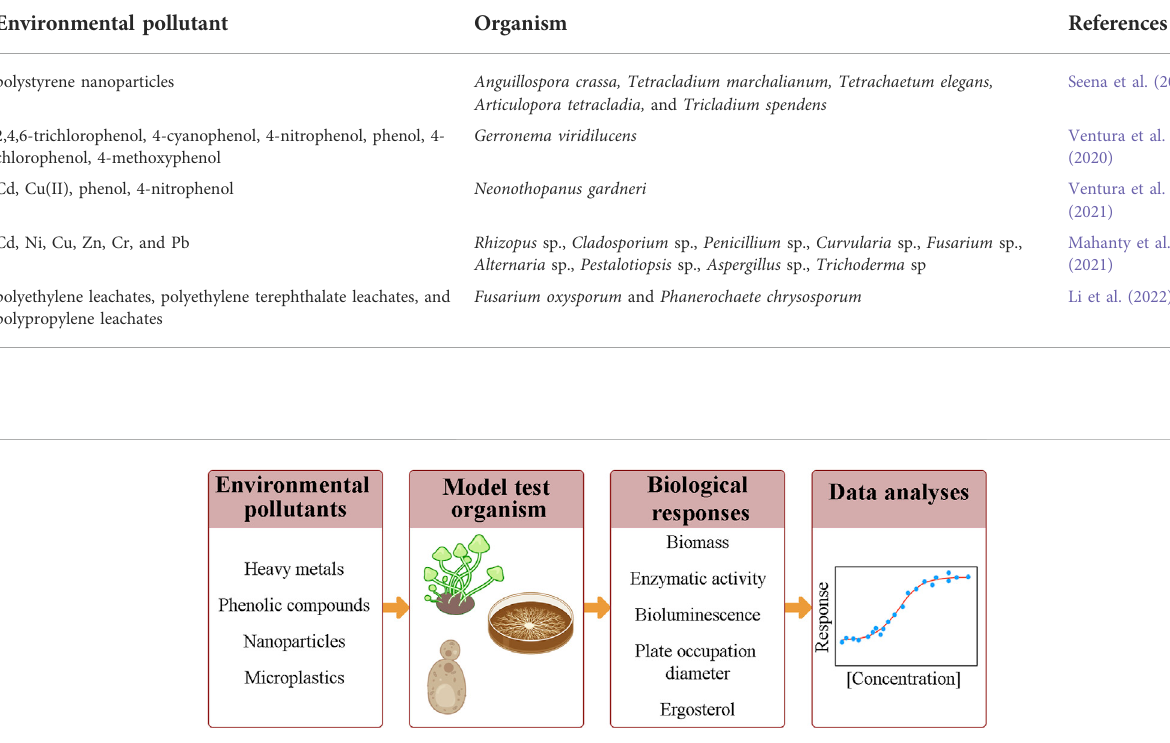
TABLE 1 Some examples of bioassays for environmental pollutants using fungal